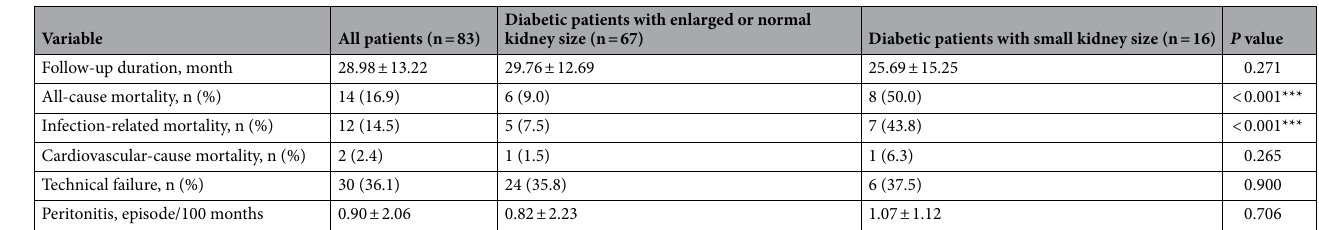
Table 4. Outcomes of peritoneal dialysis patients stratified by kidney size (n = 83). *** P <